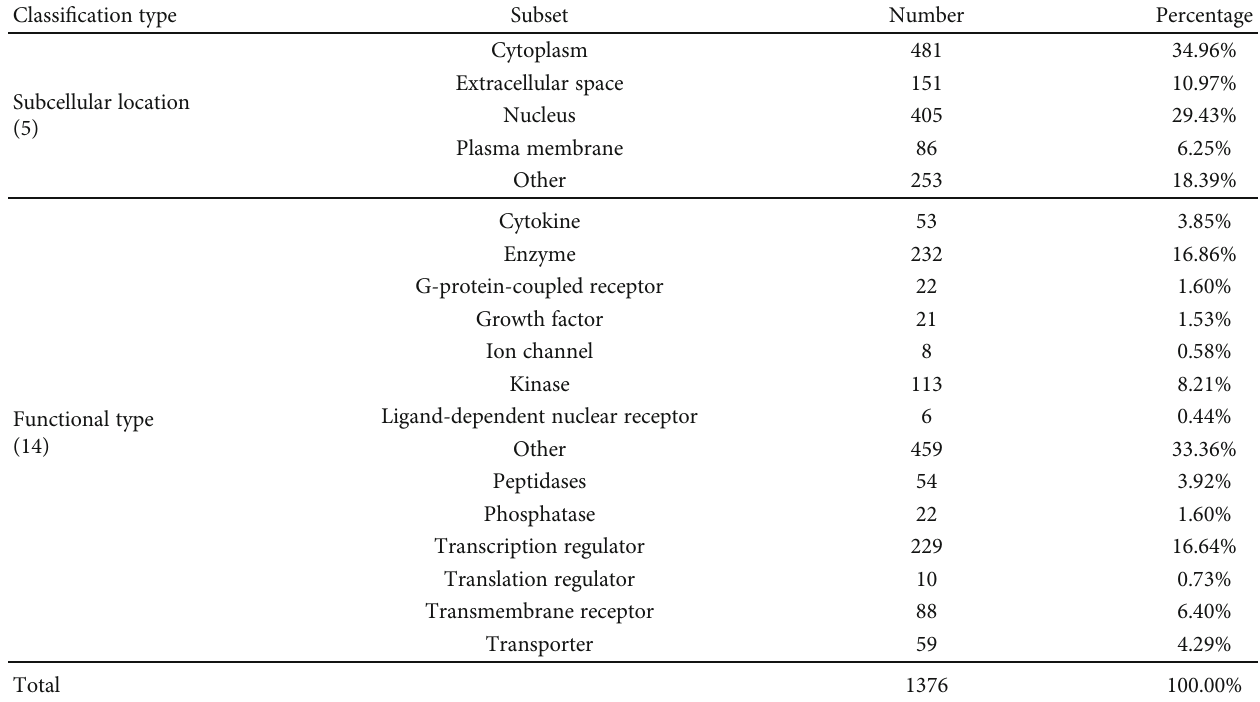
Table 2: 1376 innatomic genes ∗ were studied in this report, all of which were collected from the InnateDB # (PMID: 23180781). Classi fi cation